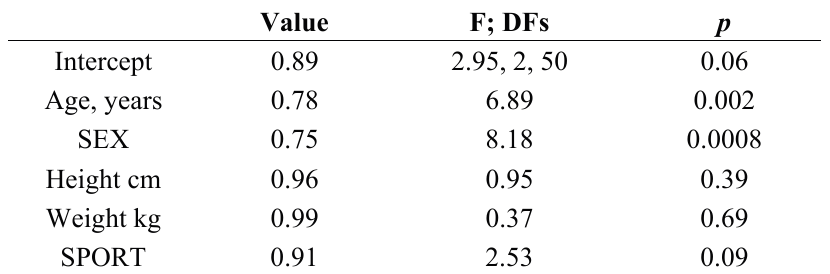
Table 3. Wilkes multivariate tests of significance from multiple